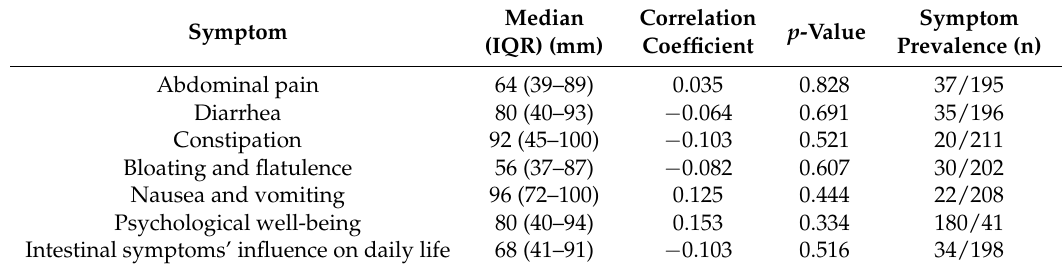
Table 3. Correlations between zonulin levels and gastrointestinal symptoms during the last 2 weeks.